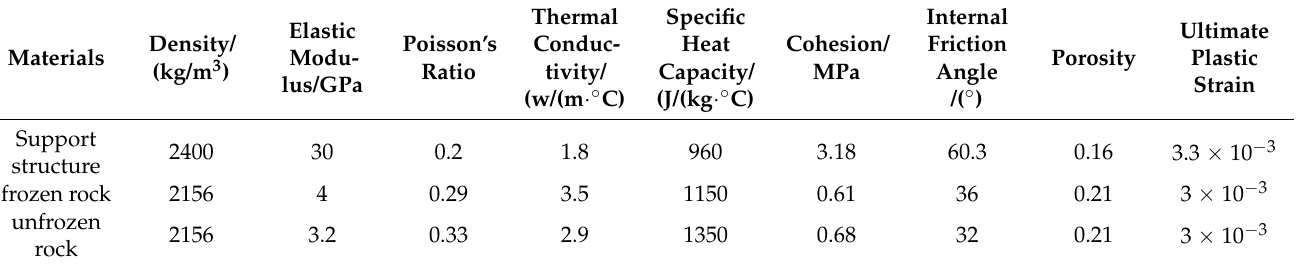
Table 1. Physical and mechanical parameters.